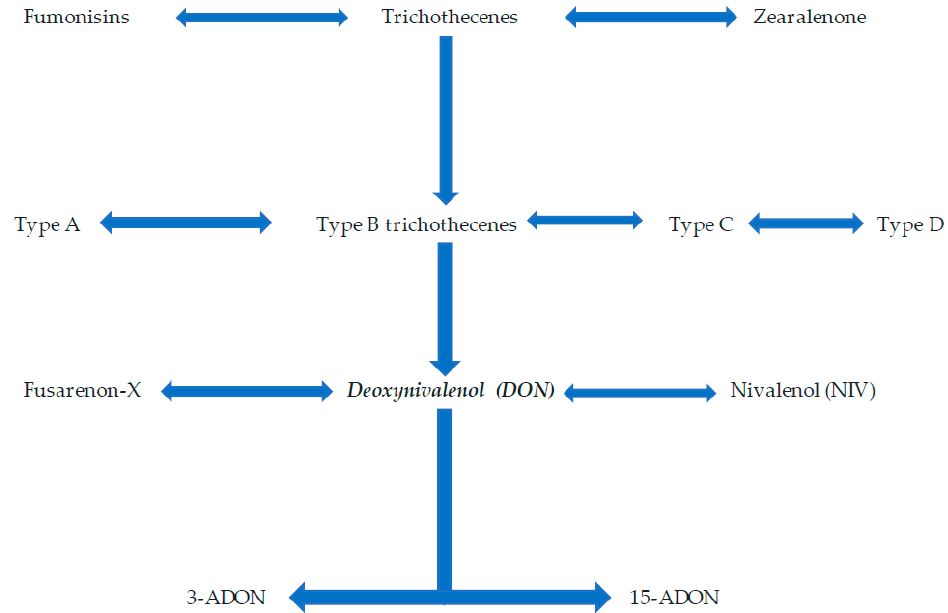
Figure 1. The classification of the major toxin produced by Fusarium graminearum , DON. The major toxins produced by Fusarium species are fumonisins, trichothecenes, and zearalenone. DON is a type B trichothecene which has derivatives 3-ADON and 15-ADON.